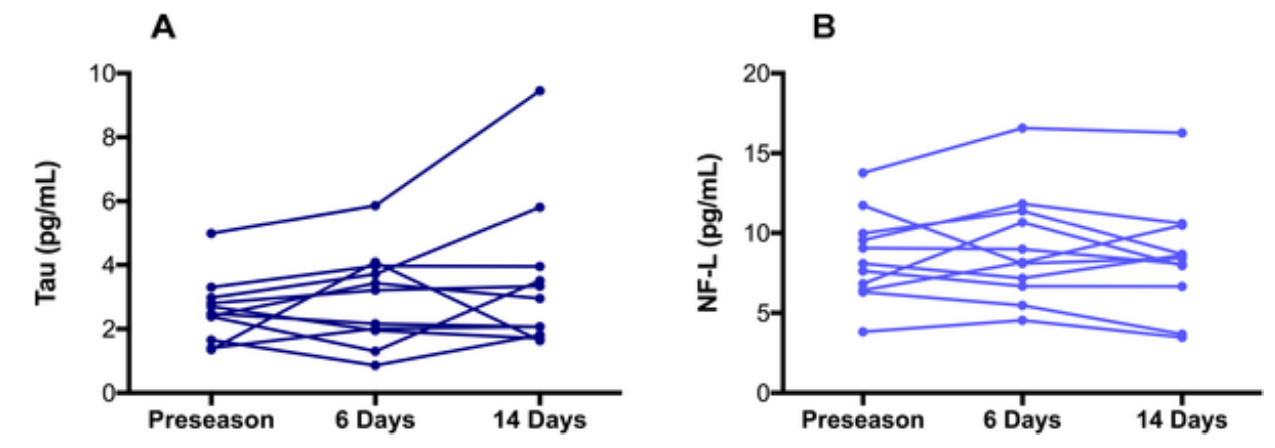
Figure 44. Kinetics of Tau ( A ) and NF-L ( B ) (data from [144]).